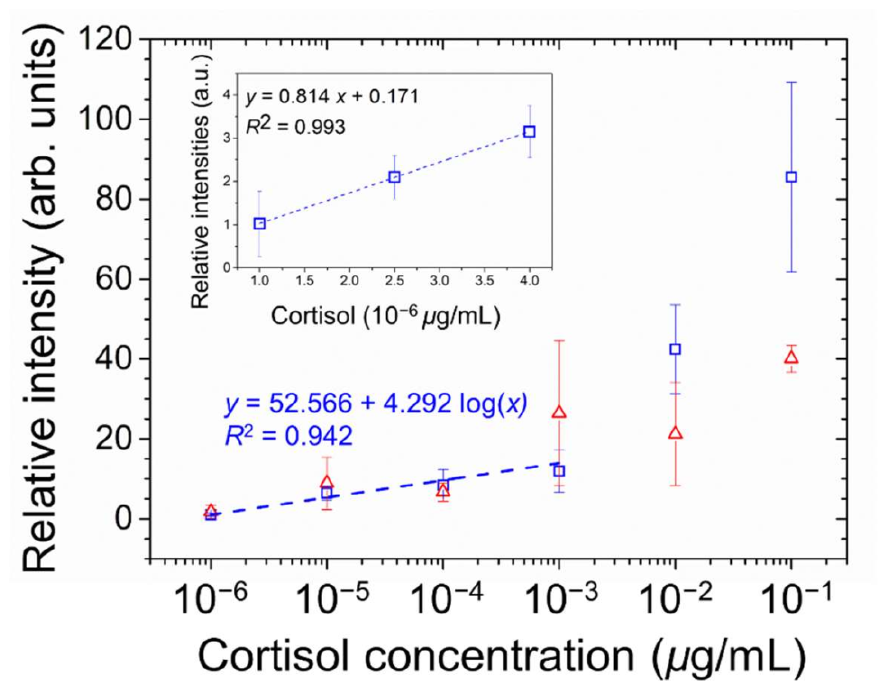
Figure 8. Quantitative analysis of the optical responses of E7 (open squares) and 5CB (open triangles) at various concentrations of cortisol on glass substrates coated with the PVA/DMOAP composite. The relative intensity of the brightness of the optical texture in Figure 7a,b were determined by the ImageJ software and plotted against the logarithm of cortisol concentration. The linear curve was illustrated in the inset to calculate the LOD. Error bars represent standard deviations calculated from at least three independent experiments. The dotted curve denotes the fitted regression line, with the coefficient of determination, R 2 , shown in the